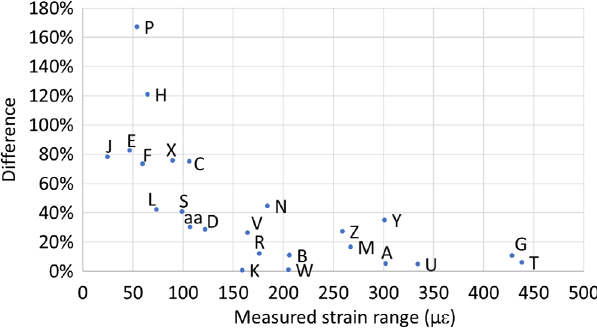
FIG. 18. Relative difference of strain range values between the simulation and the measurement vs the measured strain range. Fig. 18. The relative differences between the simulation and measurements at sensors A, G, K, T, U, and W are less than 10%. The relative differences between the simulation and measurements at sensors B, G, M, and R are less than 20%. Therefore, the simulation predicts the strain range at these locations well. As shown in Fig. 18, the simulation is always conservative because all the difference values are positive. Simulation results tend to better match the measurement data at locations where the strain range is greater than 200 με . The relative differences are largest at